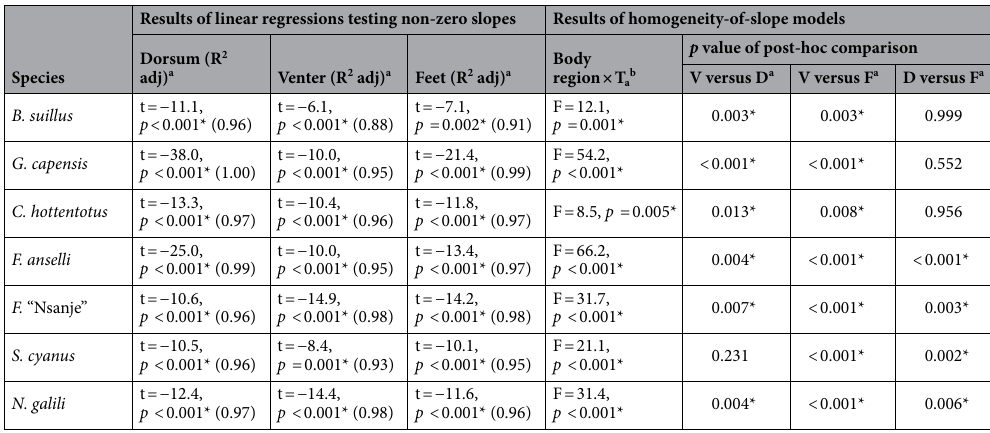
Table 3. Results of the linear regressions testing whether the slopes characterising a decrease in the change of the difference between core body and surface temperatures (T diff ) in response to increasing ambient temperatures (T a ) differ from zero for the dorsum (D), venter (V) and feet (F) and of the homogeneity-of- slope models (Body region × T a ) testing whether these slopes differ among the three body regions in seven subterranean rodent species. The degrees of freedom were 1 and 4 for the linear regressions and 2 and 12 for the homogeneity-of-slope models; the goodness of fit of the regression is presented by the adjusted R 2 ; the p value of post-hoc pairwise comparisons for the homogeneity-of-slope models are shown in the columns V vs. D, V vs. F, and D vs. F; statistically significant results after Bonferroni correction α = 0.0024 a or α = 0.0071 b applied are marked with an